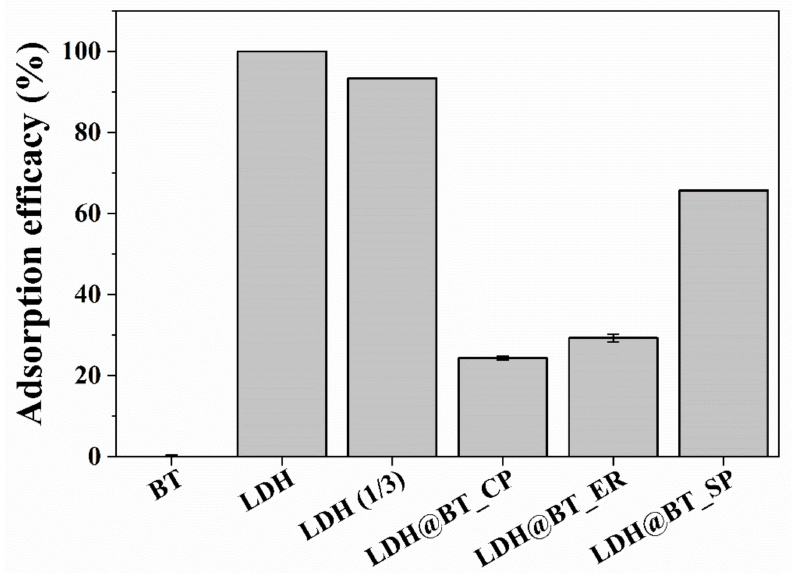
Figure 4. The chromate adsorption efficacies of the bentonite, LDH, LDH–BT_CP, LDH–BT_ER, and LDH–BT_SP (initial chromate concentration = 10 mg/L; adsorbent concentration = 1 g/L for the bentonite, LDH, LDH–BT_CP, _ER, and _SP, and 0.333 g/L for the LDH(1/3); contract time = 2 h).